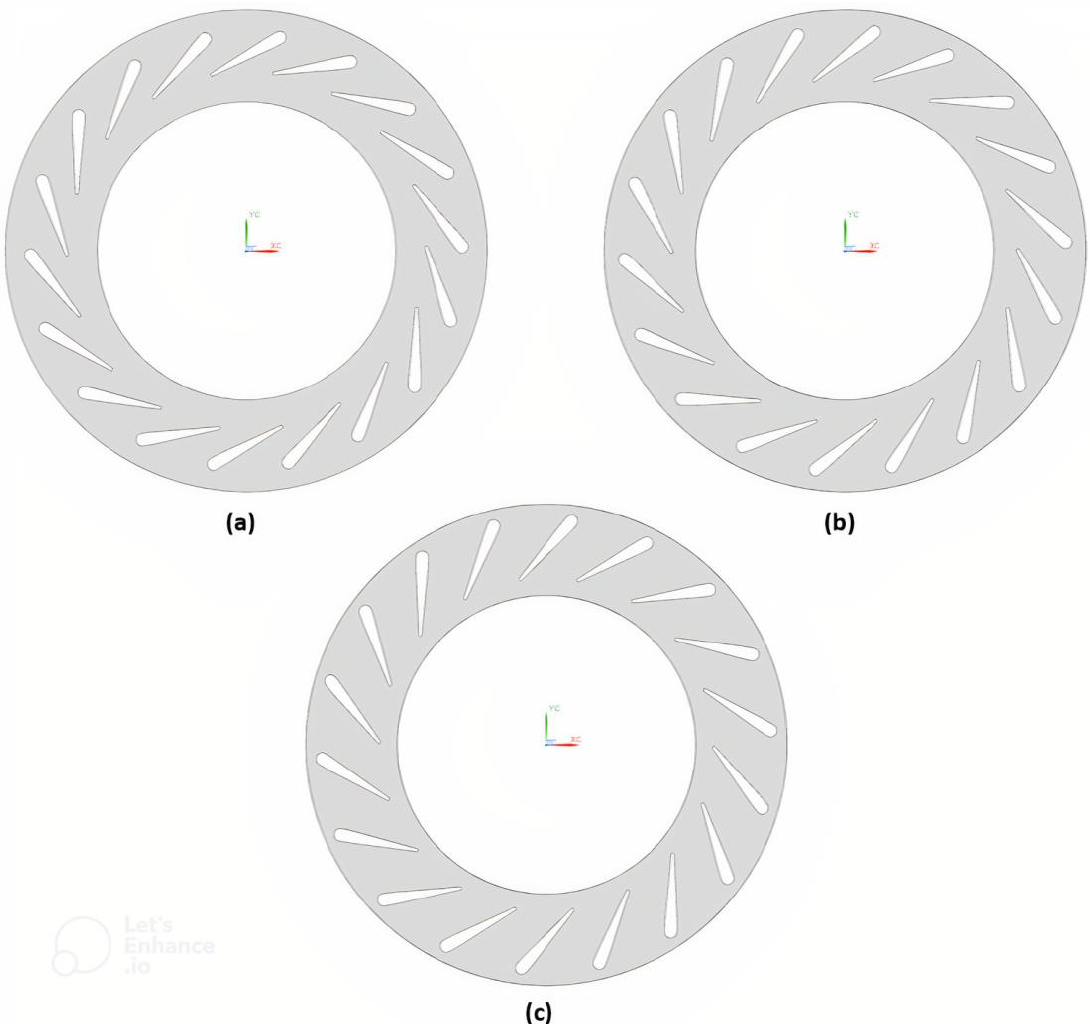
Figure 8. The position of the VTG vanes: ( a ) 20°, ( b ) 30° and ( c ) 40°.